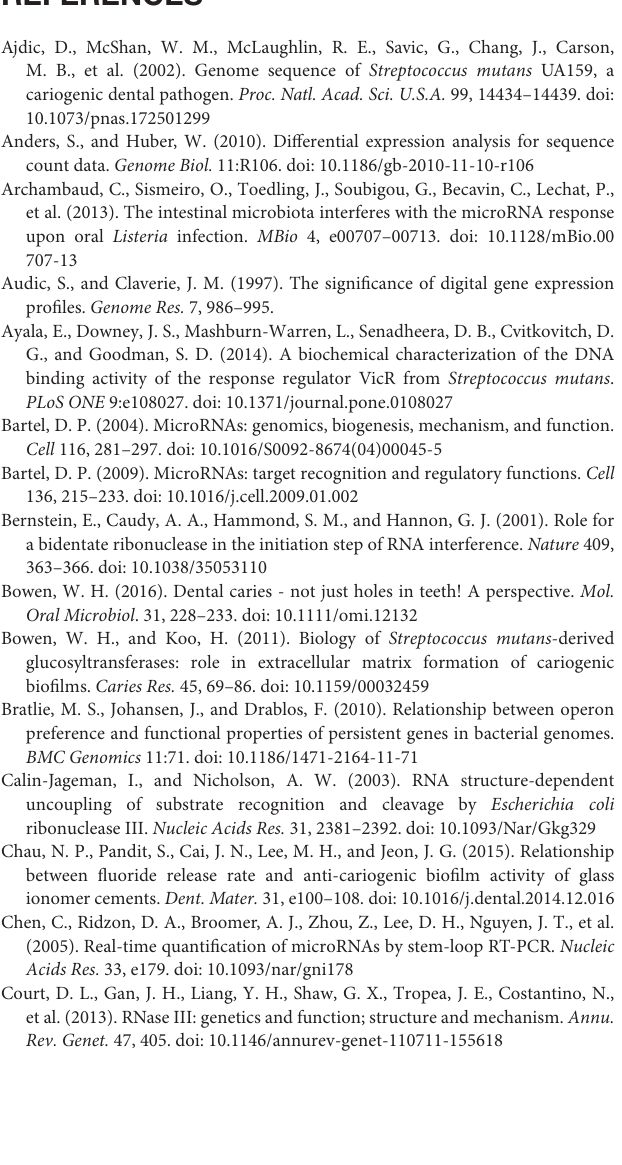
Figure S1 | Growth curves of S. mutans UA159, Smurnc, and Smurnc + . Each datum point is the average of nine independent OD values per sample. The results shown are representative of three independent experiments conducted with the mutants and UA159 parent strains. Figure S2 | Workflow to generate cDNA libraries. The directions of the arrow marks denote the flow of total RNA processing and sequential. Figure S3 | rnc affected the expression of several exopolysaccheride- related genes at the transcriptional level. The relative levels of target gene expression in UA159 and Smurnc were determined at mid-exponential phase in vitro . The fold changes are shown after standardization relative to gyrA using UA159 as a reference. Figure S4 | Workflow to analyze and select the validated msRNAs. The directions of the arrows denote the flow of data processing and sequences. The shapes of the boxes have no particular significance, while the descriptions within the boxes represent the steps corresponding to data